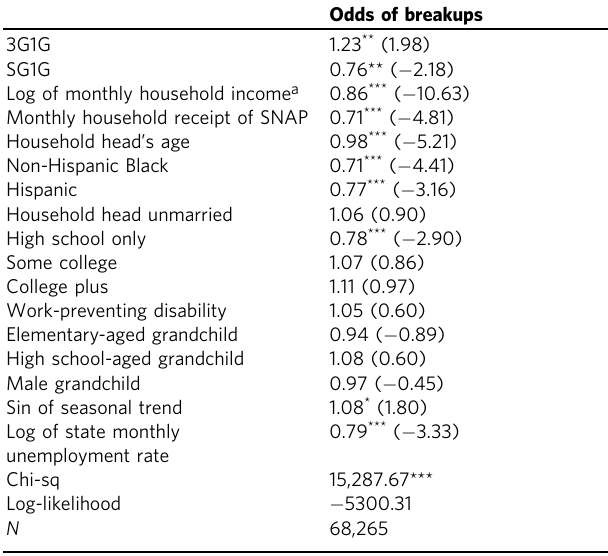
Table 3 ’ s results con fi rmed our hypothesis that variation in odds of dissolutions among intergenerational households is tied to generational hierarchy. Controlling for socioeconomic and demographic measures, the estimated coef fi cient for 3G1G households suggests that the odds of breakups are higher than for